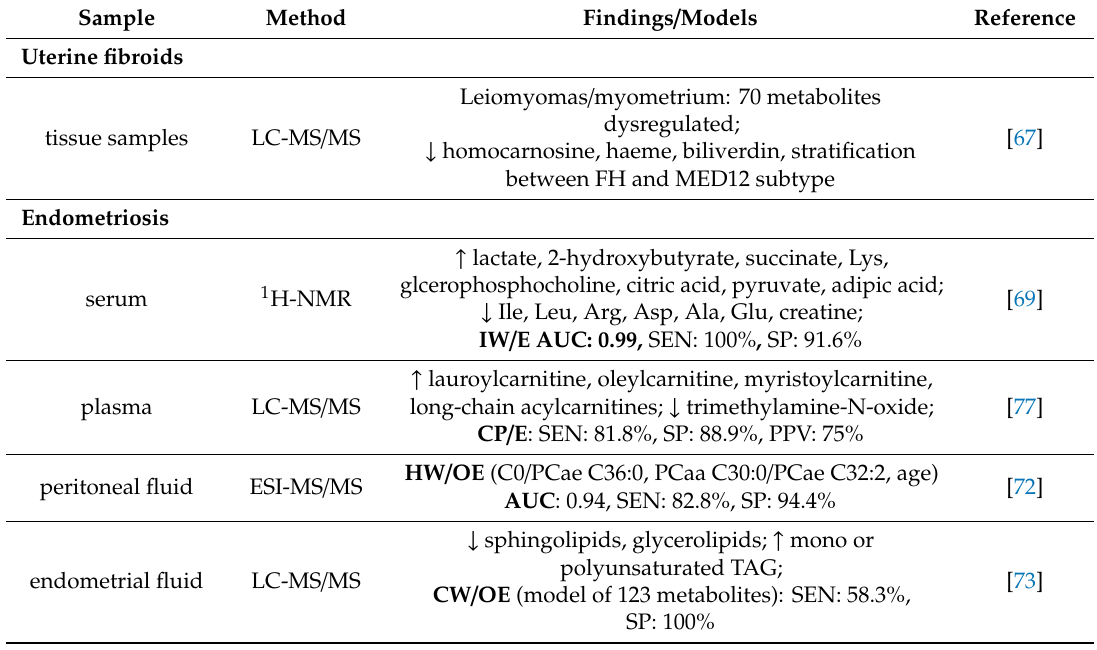
Table 3. Selection of studies that reported diagnostic and prognostic models potentially relevant for clinical